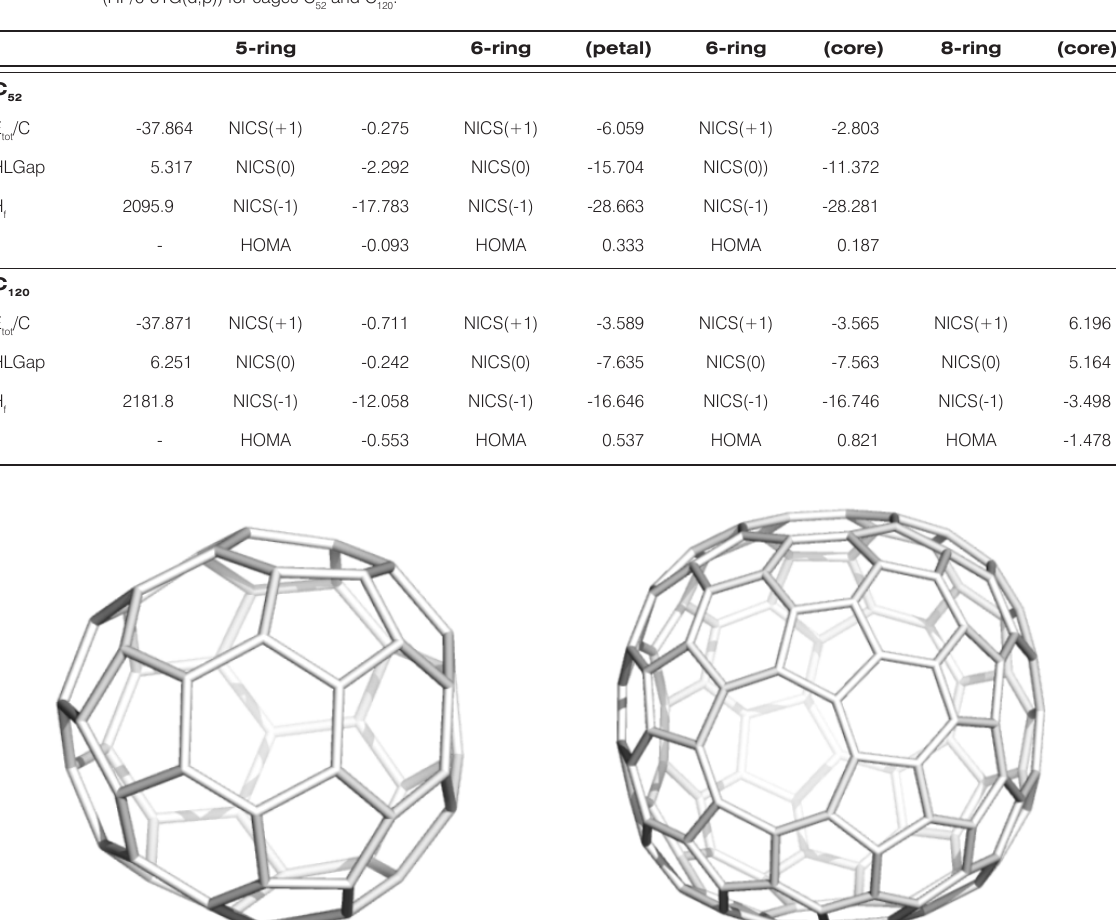
(kJ mol -1 ), NICS and HOMA values f